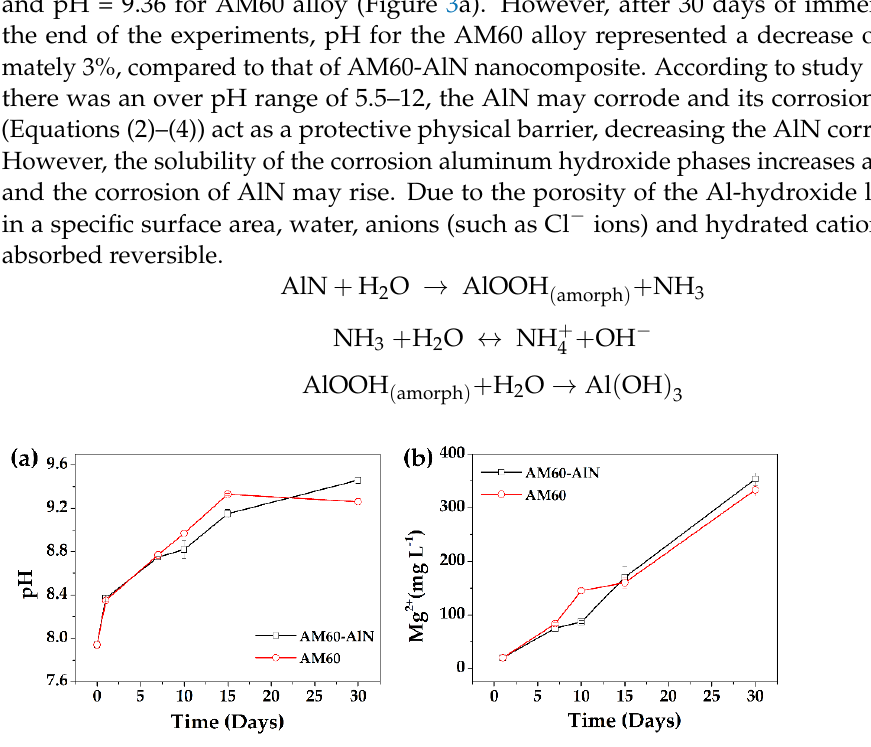
Figure 2. Roughness values ( R a ) of reference samples of ( a ) nanocomposite AM60-AlN and ( b ) AM60 alloy.